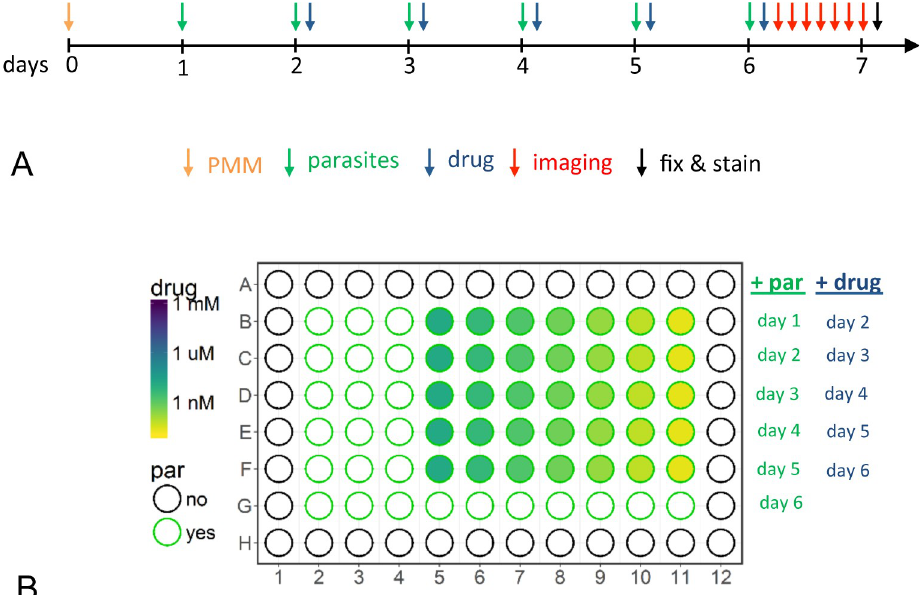
Fig 2. Assay design. The timeline of the experimental set-up (A) and plate design (B). On a 96 well plate, a new set of wells containing expanded peritoneal mouse macrophages (ePMM) was infected every 24 h. Extracellular parasites were removed 24 h hpi and drugs were added in 3-fold serial dilution. On day 6, after addition of parasites and drugs (either benznidazole or posaconazole), the plate was imaged on 9 sites per well over 24 h every 4 h (live imaging). After 24 h live imaging, the plate was fixed and stained with Hoechst 33342 and imaged again (fixed imaging). Green fluorescent parasites per image were detected for all images (from live and fixed imaging) of the green fluorescent channel. Kinetoplasts per image were detected on images of the DAPI channel (fixed